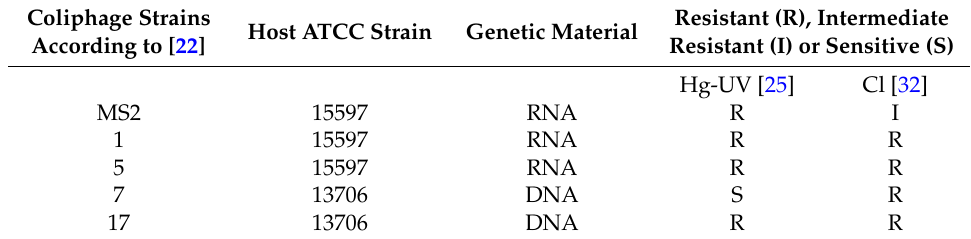
Table 1. Genetic material of coliphages tested with RNase spot test and sensitivity of coliphages to Hg-UV and